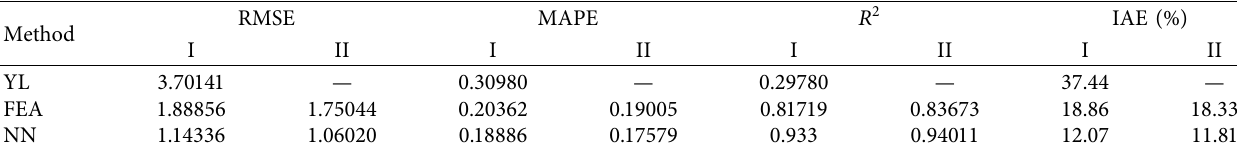
Table 6: Statistical analysis of failure load prediction between YL, FEA, and NN